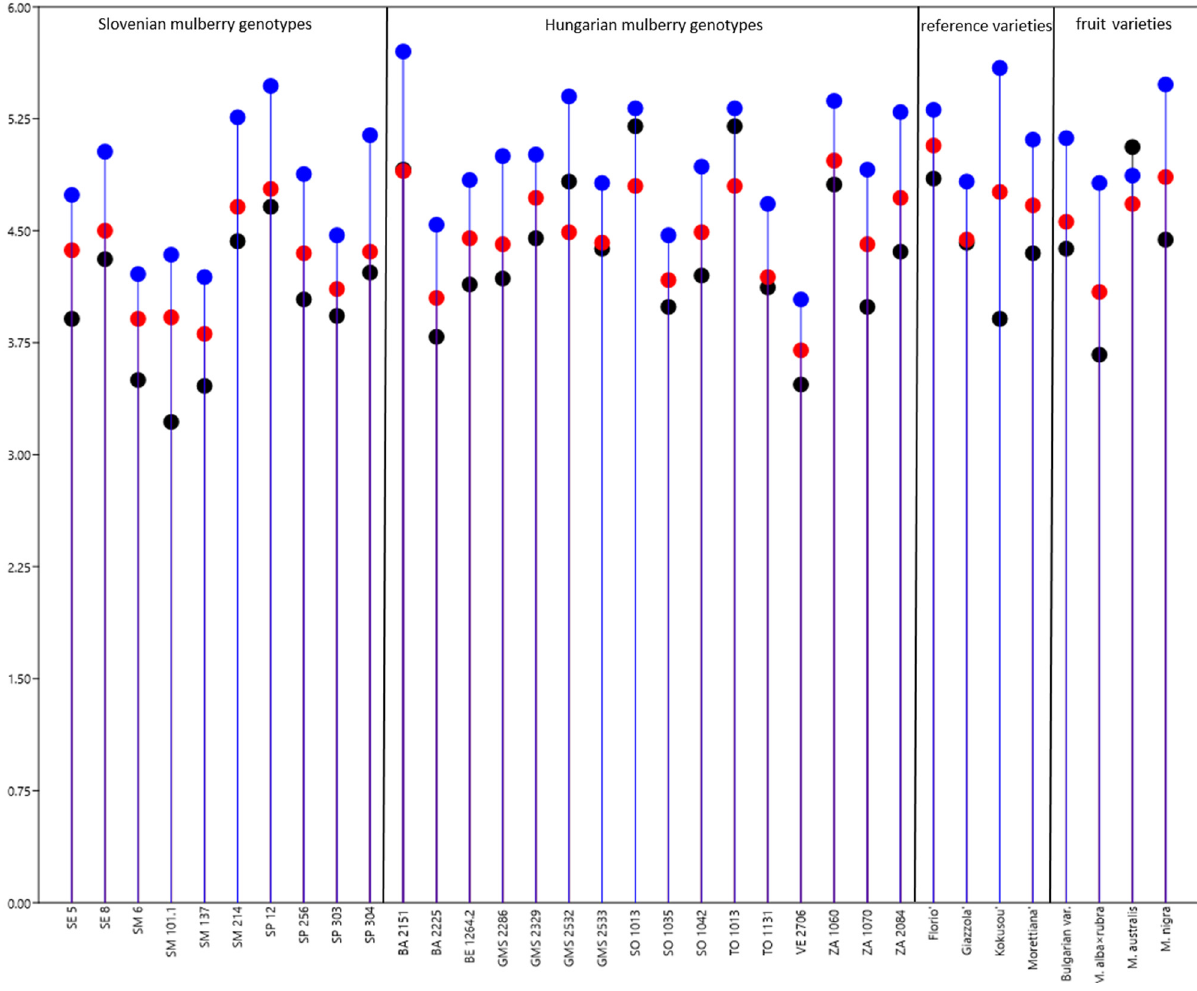
Figure 3. Mean weight of a larvae (±SD) on day 5 (black dots), 6 (red dots), 7 (blue dots) of the fifth instar when fed with Slovenian, Hungarian mulberry varieties, reference sericultural varieties, and fruit varieties. For detailed data and statistics see Table 3 and Supplementary Table S4. Table 3. Mean weight (±SD) of a larvae and cocoon fresh weight (FW, g) when fed with Slovenian, Hungarian mulberry varieties, reference sericultural varieties, and fruit varieties. Different letters (a, b) indicate significant differences ( p < 0.05), which were determined using the post hoc Duncan test. FW, fresh weight. n , number of repetitions.